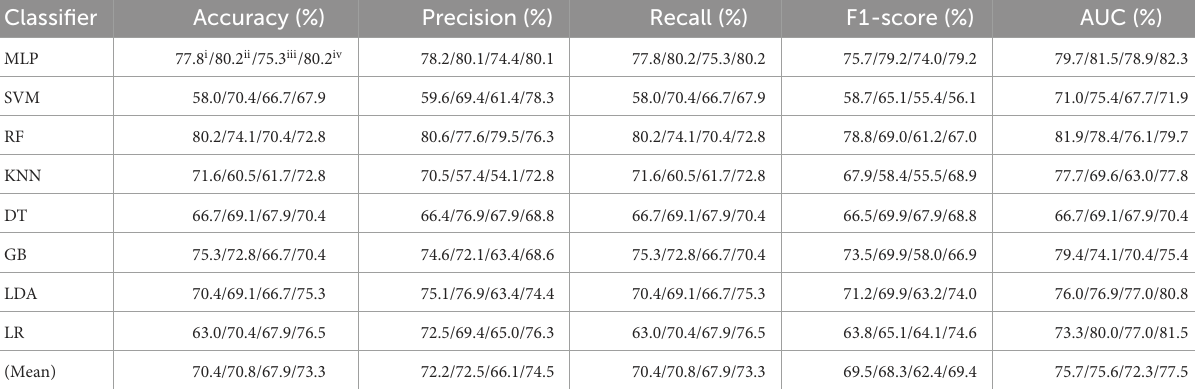
TABLE 6 Evaluation metrics of the different classifiers with four fused combination features (Experiment 3) on the test set,